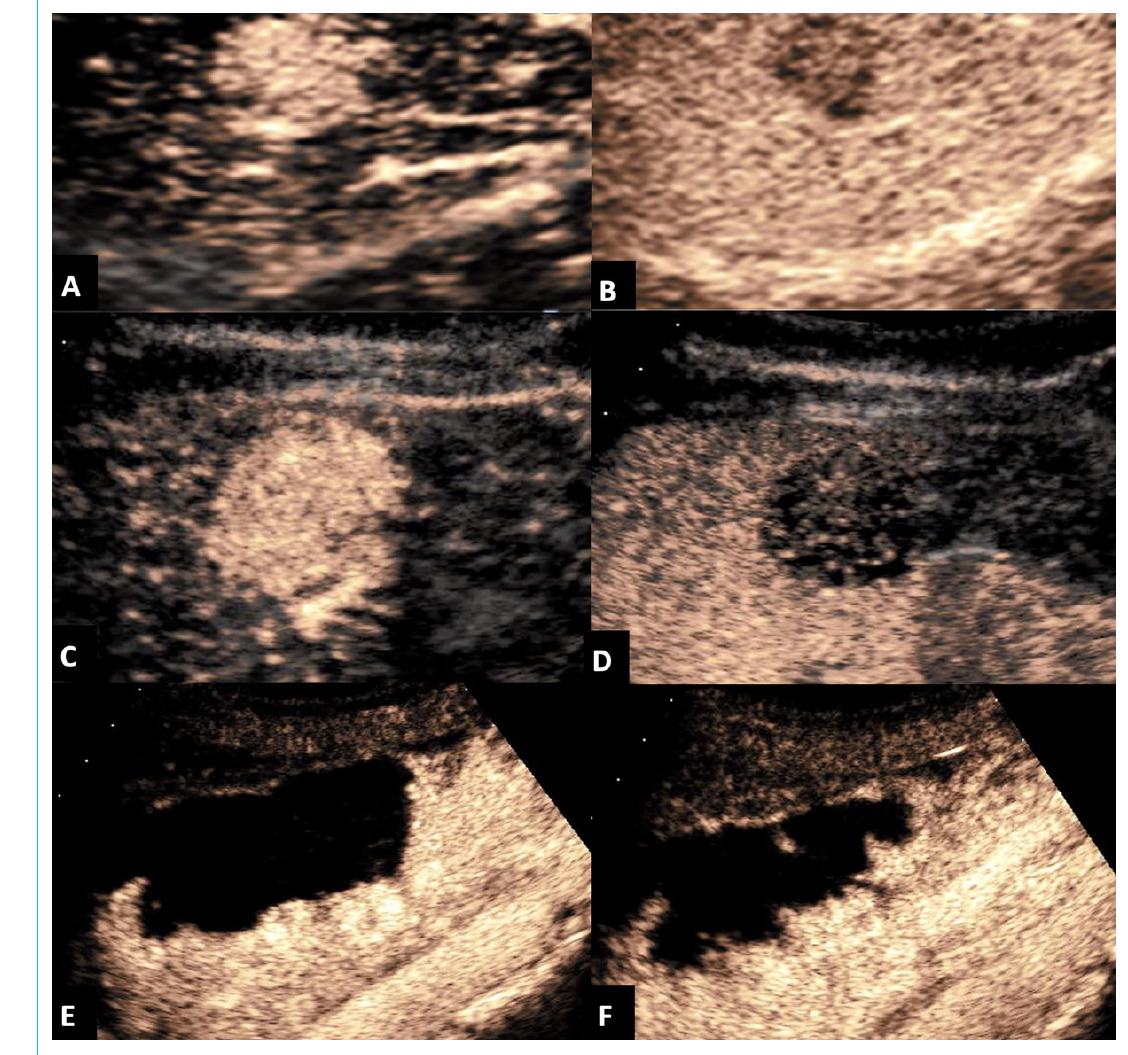
Figure 1: Contrast-enhanced ultrasound (CEUS) of (A) a cholangiocarcinoma showing early arterial enhancement and (B) wash-out in the ve- nous phase. CEUS of a primary B-cell lymphoma demonstrating (C) early arterial enhancement at 15 seconds and (D) wash-out in the portal venous phase. CEUS of a haemangioma showing centripetal enhancement (E) at 21 seconds and (F) at 43